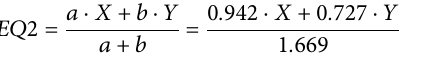
Frontiers in Environmental Science |